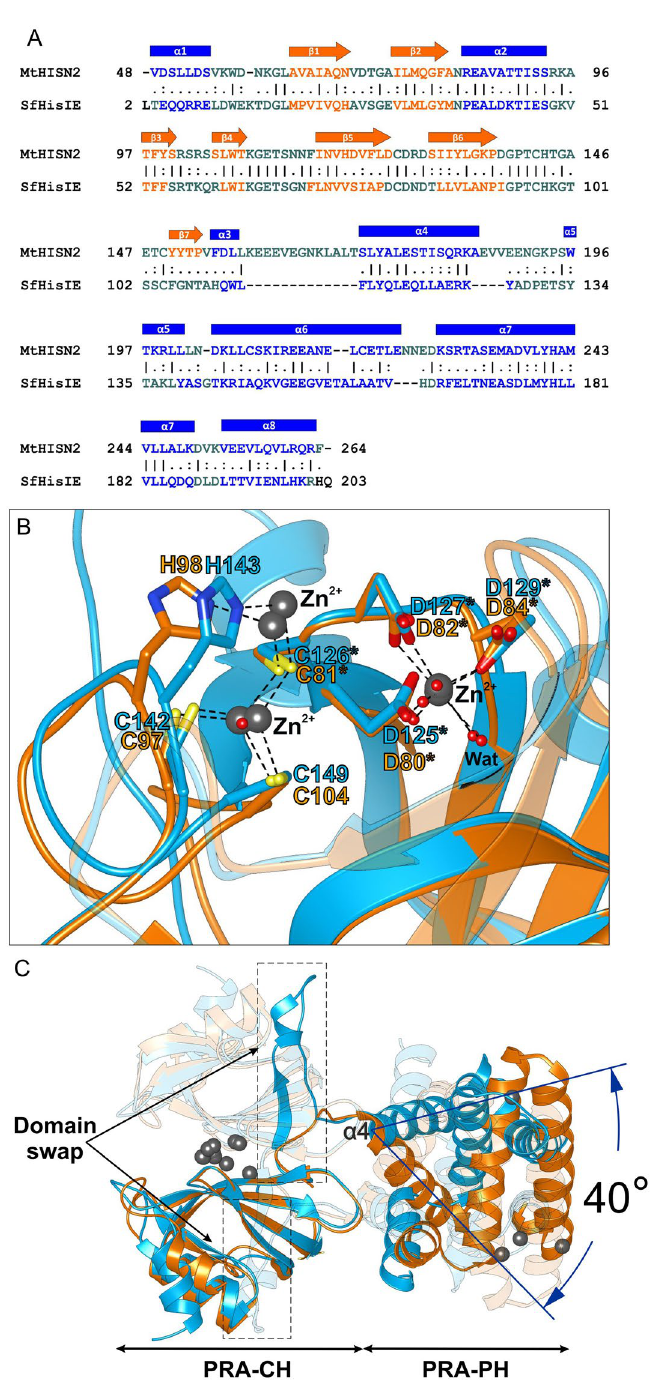
Figure 5. Comparison of a bacterial bifunctional HisIE enzyme and plant Mt HISN2. Panel A shows a sequence alignment of Mt HISN2 and Sf HisIE (35% identity; PDB ID: 6J2L). Secondary structure elements are colored in blue (α-helices) and orange (β-strands). B Superposition of MBSs in the PRA-CH domains of Mt HISN2 (blue) and the Sf HisIE (orange), made up by evolutionary conserved residues coordinating Zn 2+ (dim gray). Superposition of the two structures in panel C reveals well-aligning PRA-CH domains, whereas PRA-PH domains are rotated by 40°, measured between the α4 helix in Mt HISN2 and its counterpart in Sf HisIE. The second subunits of both dimers are transparent for